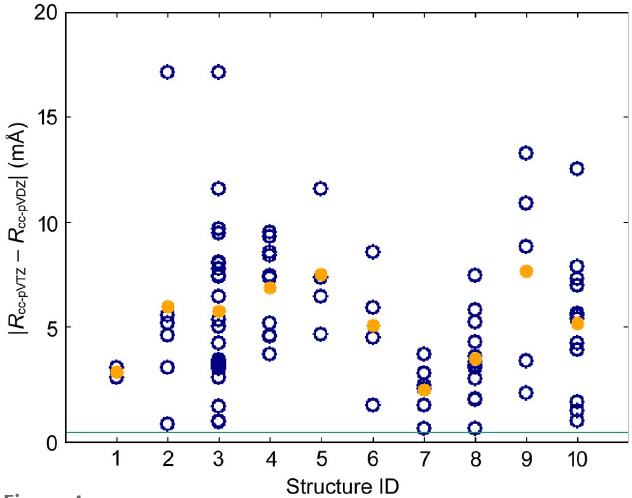
Figure 4 Absolute difference in X —H bond lengths for HAR with two different basis sets: cc-pVDZ and cc-pVTZ. Each bond is represented by a dark blue circle. Structure IDs ( x axis) refer to the labelling in Fig. 3. Orange circles correspond to the average for a given